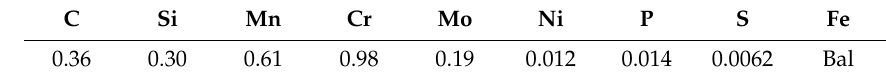
Table 1. Chemical composition of 35CrMo steel (wt%).